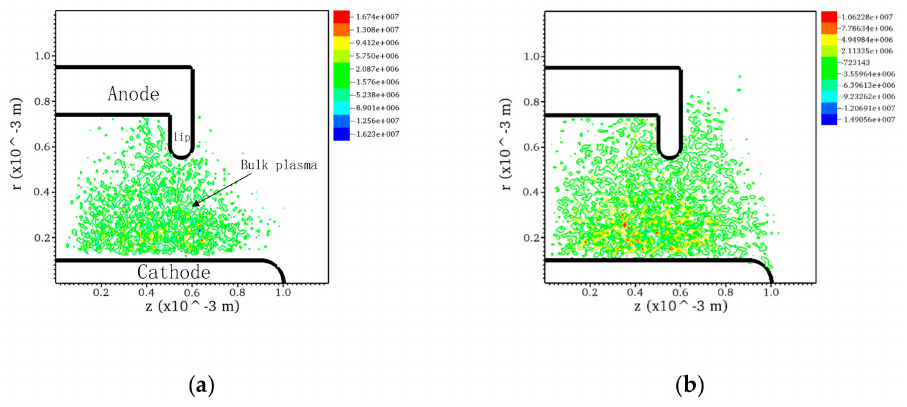
Figure 5. Contour plots of axial ( a ) and radial ( b ) current density (A / m 2 ), (400 A, 100 V, 4 g / s, 5 × 10 − 9